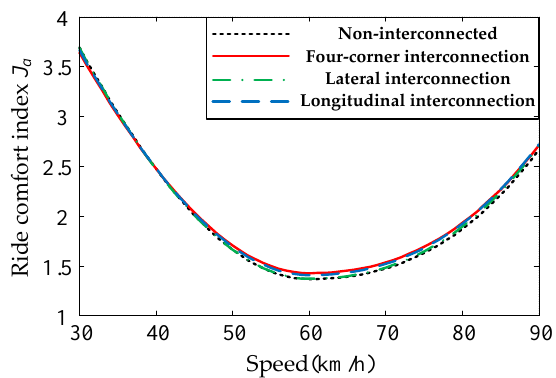
Figure 6. Ride comfort index J a under the steering condition.